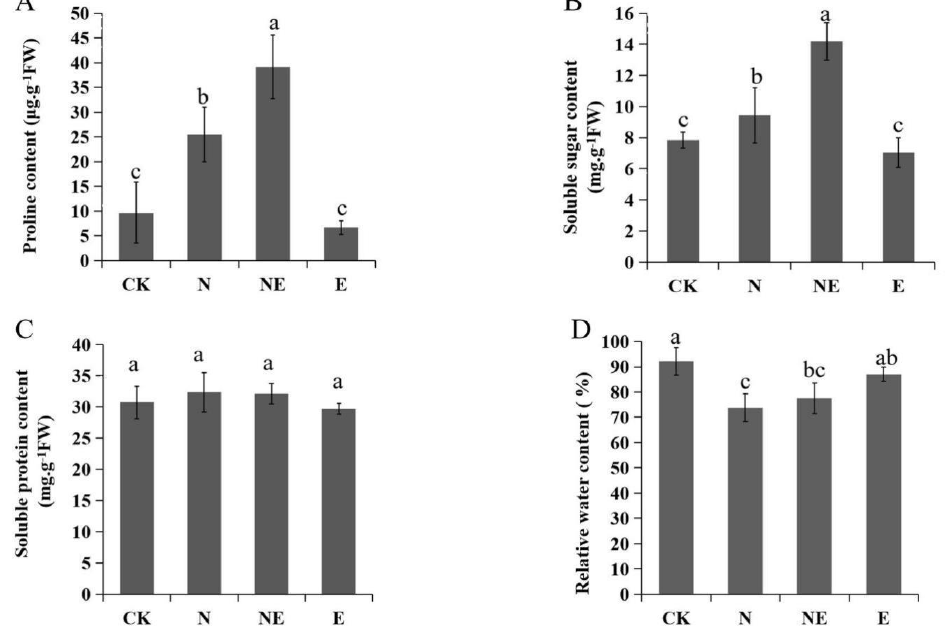
Figure 4. Effects of EBL treatments on osmolytes content and RWC of peanut seedling under salt stress. CK (normal conditions), N (treated with 150 mM NaCl), NE (treated with 150 mM NaCl and 0.1 µ M EBL) and E (treated with 0.1 µ M EBL). ( A ) Soluble sugar content; ( B ) Proline